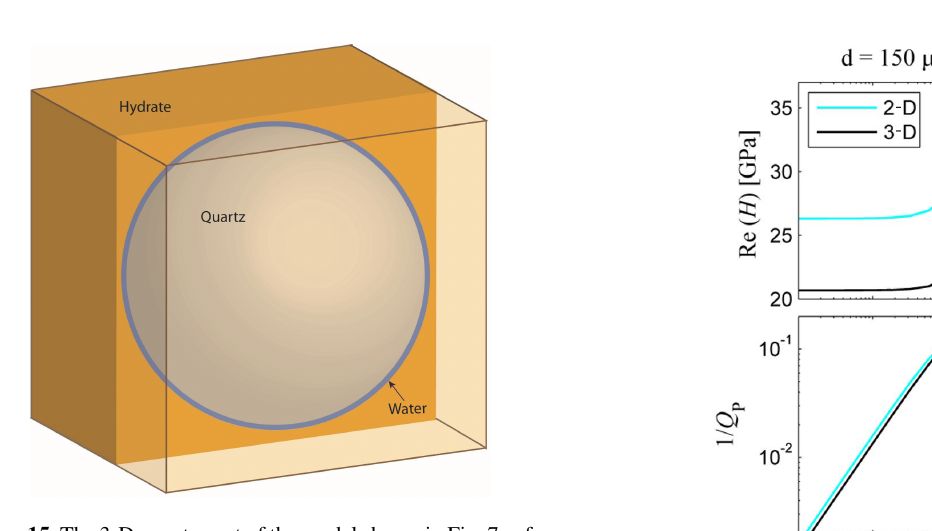
Figure 15. The 3-D counterpart of the model shown in Fig. 7: a fun- damental block of a periodic medium representing unconsolidated quartz grains which are separated from the embedding GH back- ground by a thin interfacial water film.